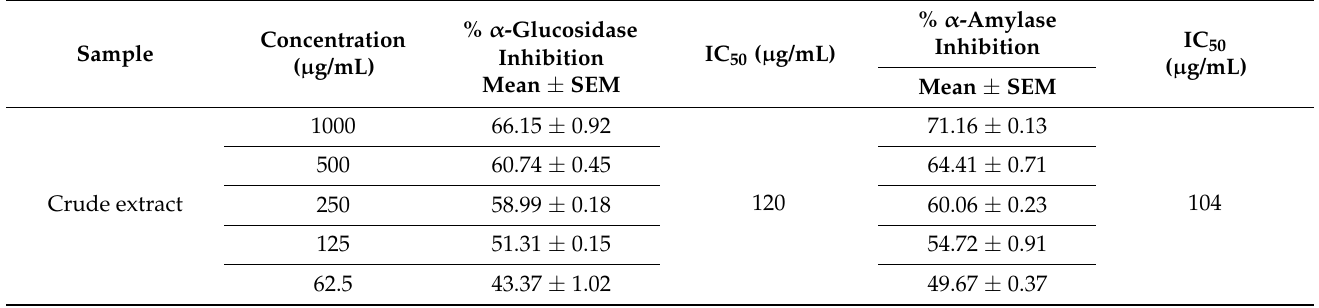
Table 6. α -glucosidase and α -amylase enzyme inhibition of crude and Ext+Ch NPs, Ext+PEG NPs, and Ext+LGB NPs at the highest